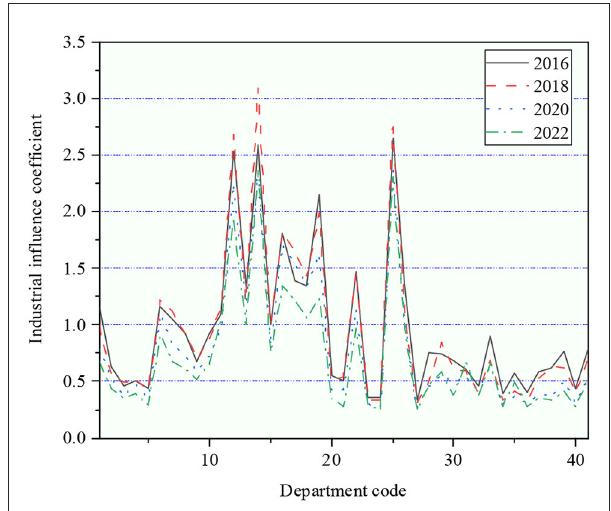
FIGURE7 Overall economic indicators for 2017 and 2022.